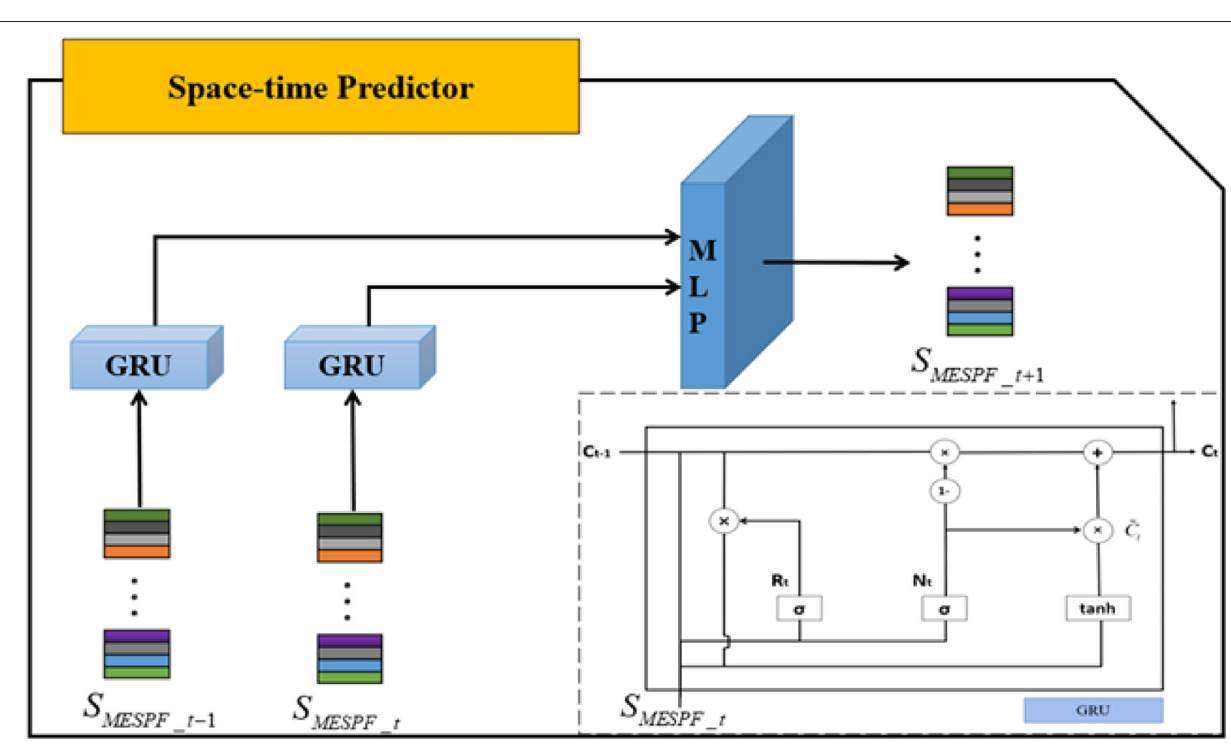
FIGURE 5 | The core part of space-time predictor is gate recurrent